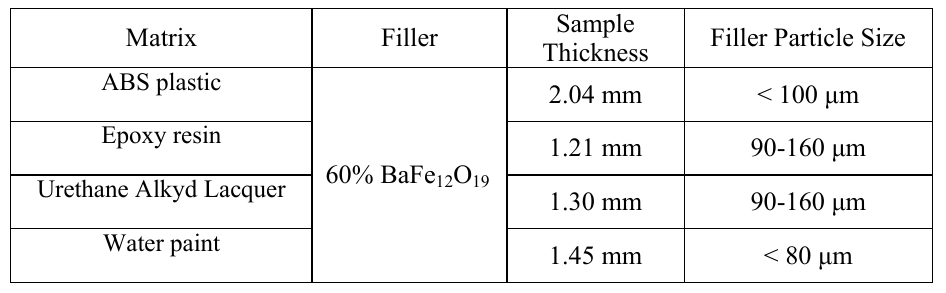
Table 1. Characteristics of the samples